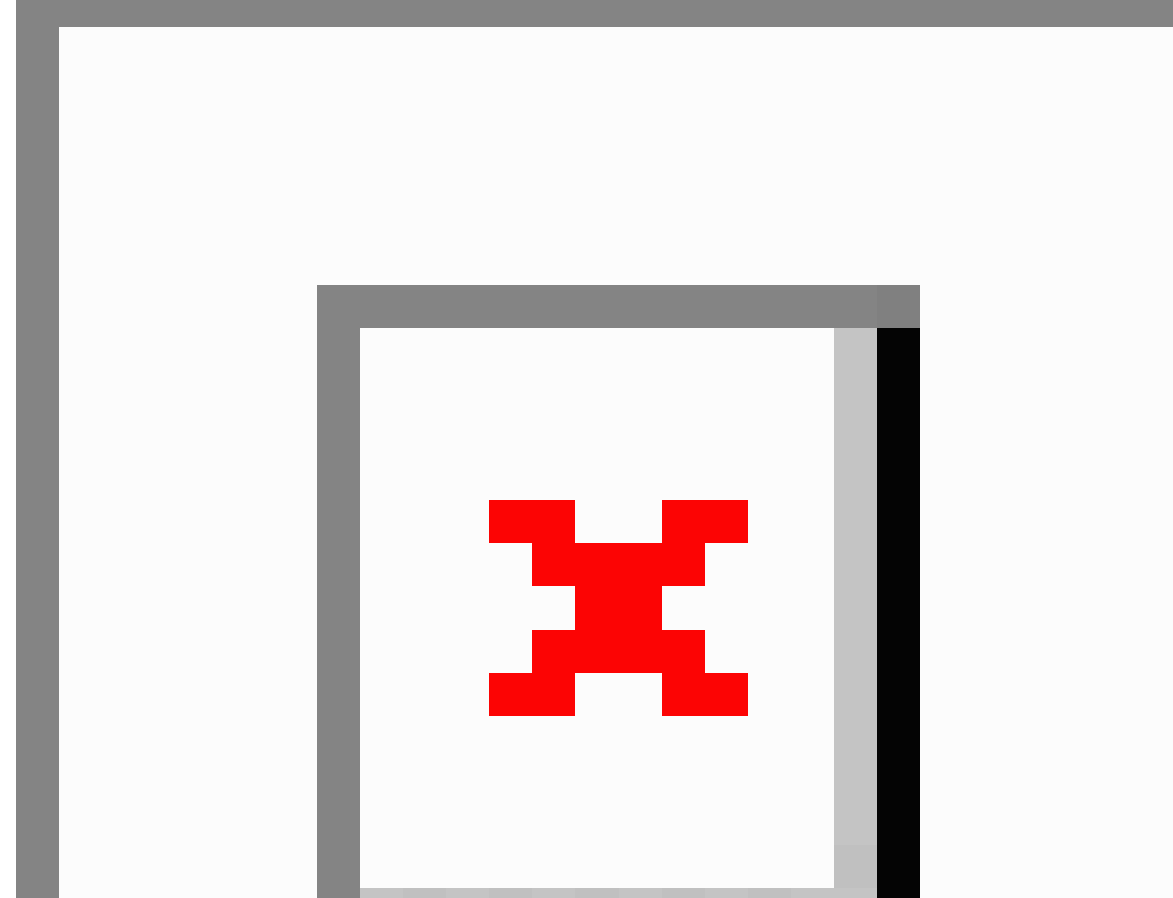
Figure 4. Population distribution by age in the surveys. Data are presented as the mean and standard deviation, which is indicated by error bars. Age is given in